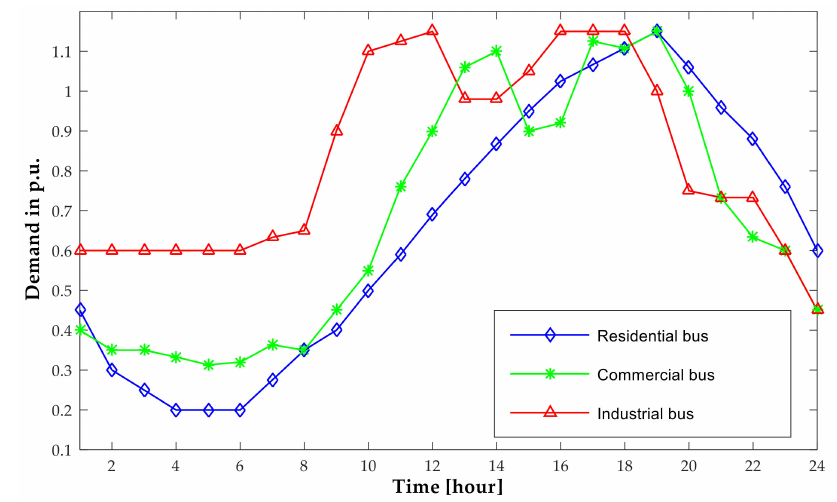
Figure 1. Typical buses load curve,